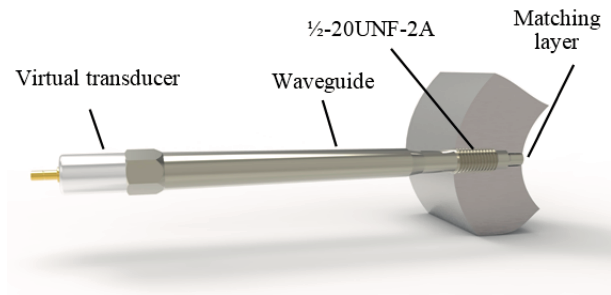
Figure 10. Graphical representation of the 3D